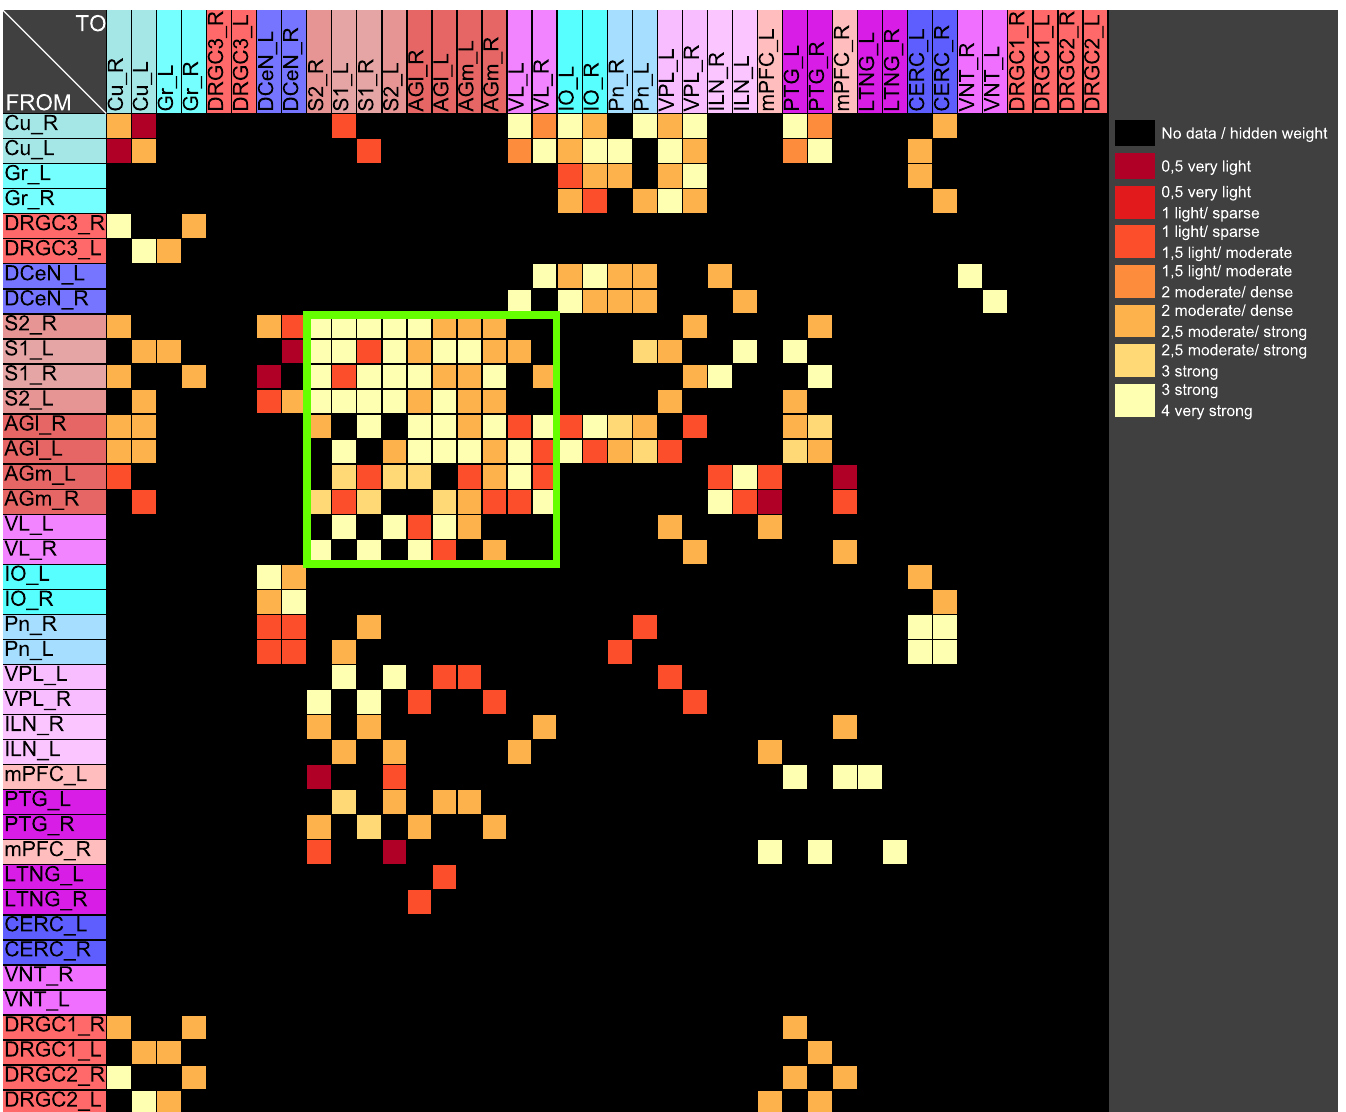
Fig 7. Average cross-correlation matrix of four parameters. The average cross-correlation of the variation of the two reaction constants and the two decay parameters for activators and inhibitors has been analyzed by spectral clustering. A similar group of regions (green rectangle) could be determined as found with a two parameter